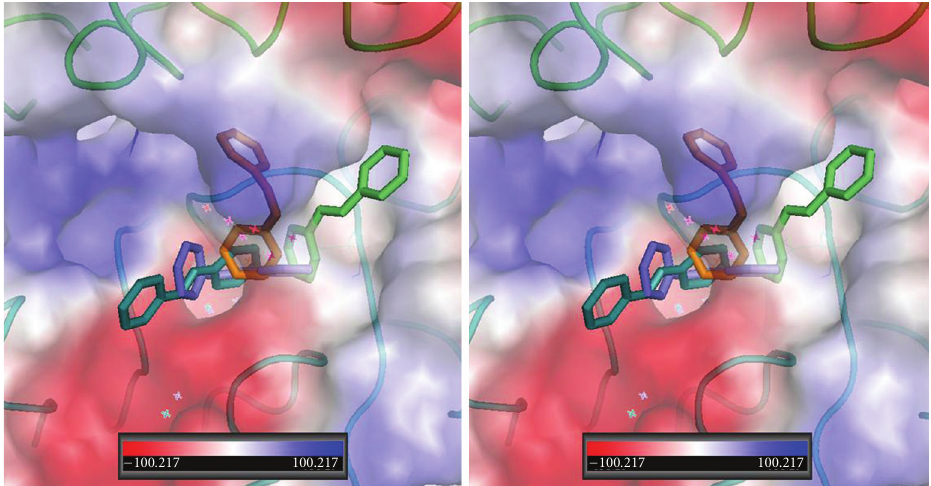
Figure 11: Stereoview of α v β 3 integrin RGD showing cis -stilbene (gold, Ca1), cis -stilbene (cyan, Ca2), trans -stilbene (green, Ca1), and trans -stilbene (purple, Ca2) and the residues that make contact with the RGD